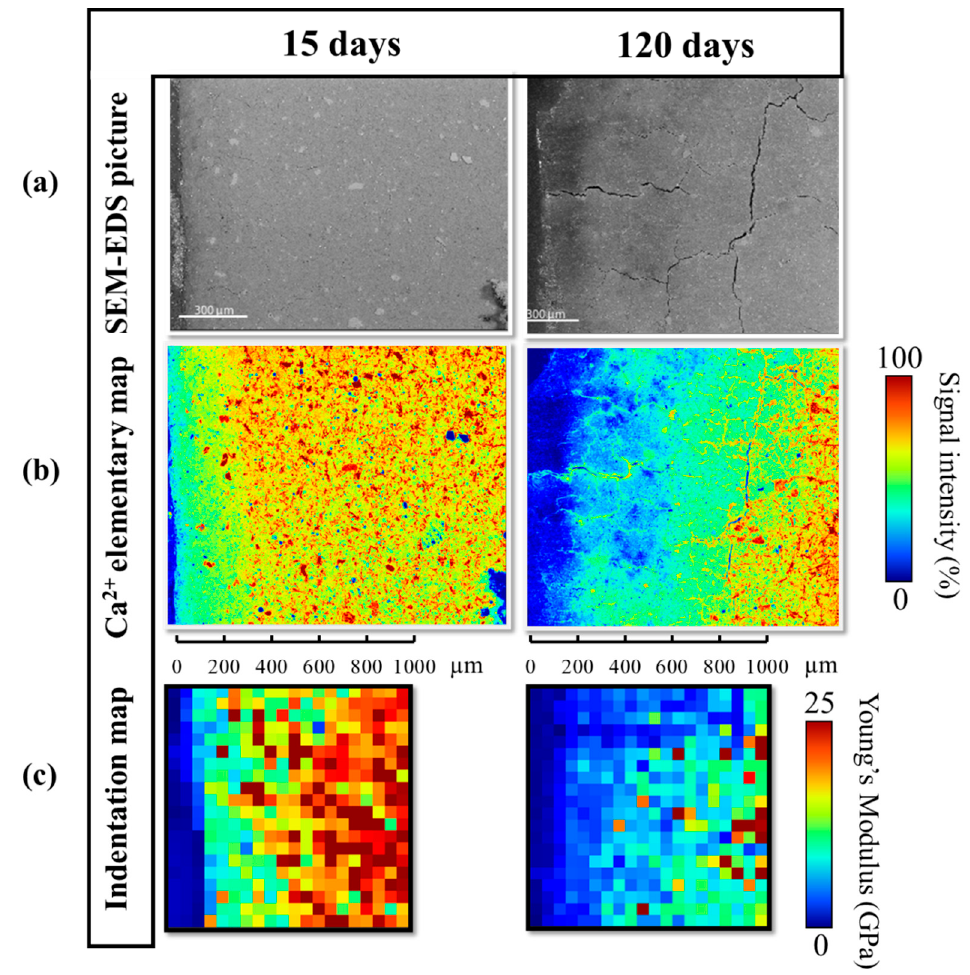
Figure 6. SEM–EDS picture ( a ), Ca-elementary map, ( b ) and Young’s modulus map ( c ) of the degraded cement pastes after 15 and 120 days.